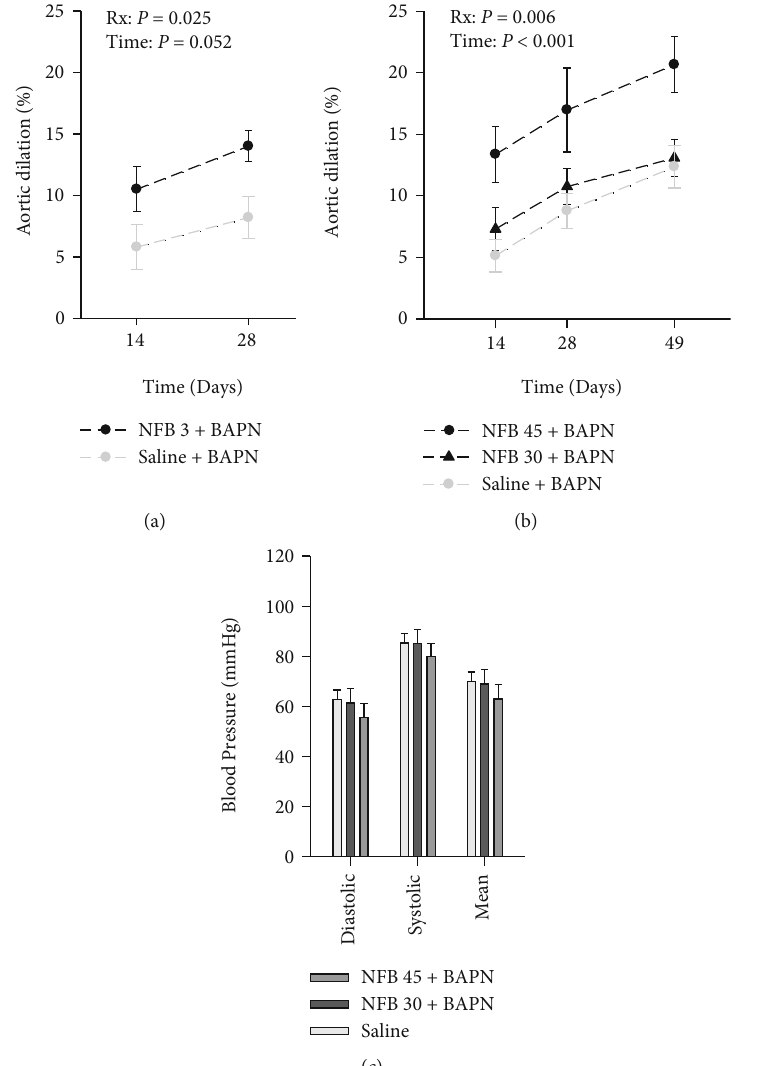
Figure 2: β -Aminopropionitrile (BAPN) sensitizes the response of TAADs to nicotine free base (NFB). (a, b) E ff ect of low (3.0 mg/kg/day, (a)) and high (30.0 or 45.0mg/kg/day, (b)) doses of NFB on the growth of TAADs in mice given 0.2% BAPN; n = 5 ‐ 7 and n = 10 ‐ 17 per group for low- and high-dose experiments, respectively. (c) Blood pressure of mice exposed to high doses of NFB or saline on d49. Data were analyzed using two-way repeated measures ANOVA (a, b), or one-way ANOVA